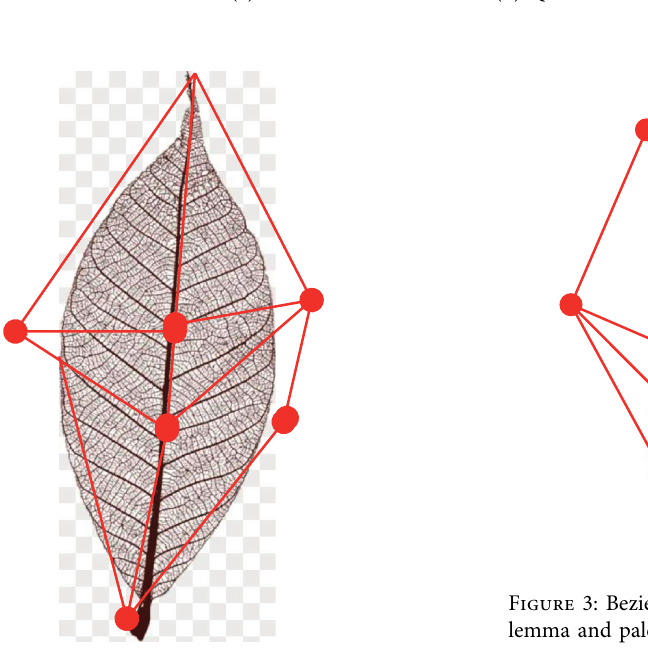
Figure 1: Bezier curve. (a) First-order Bezier curve. (b) Quadratic Bezier curve. (c) Cubic Bezier